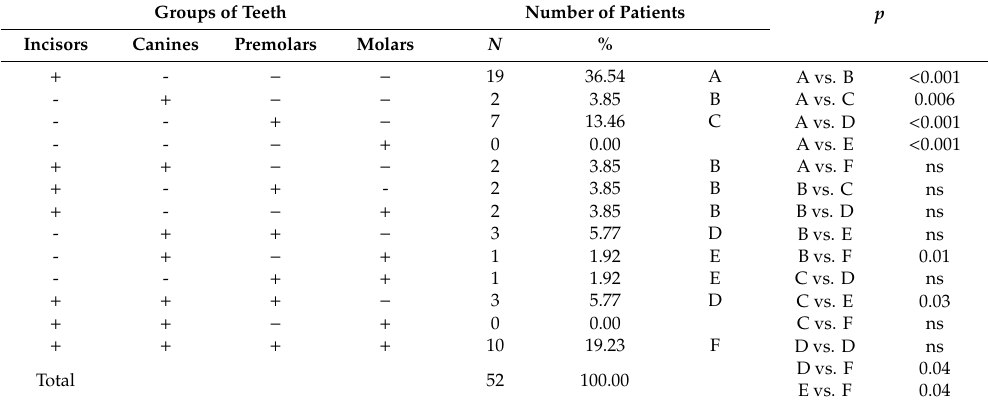
Table 8. Number of students with enamel opacities with respect to particular groups of teeth (at least one tooth had to be a ff ected in the